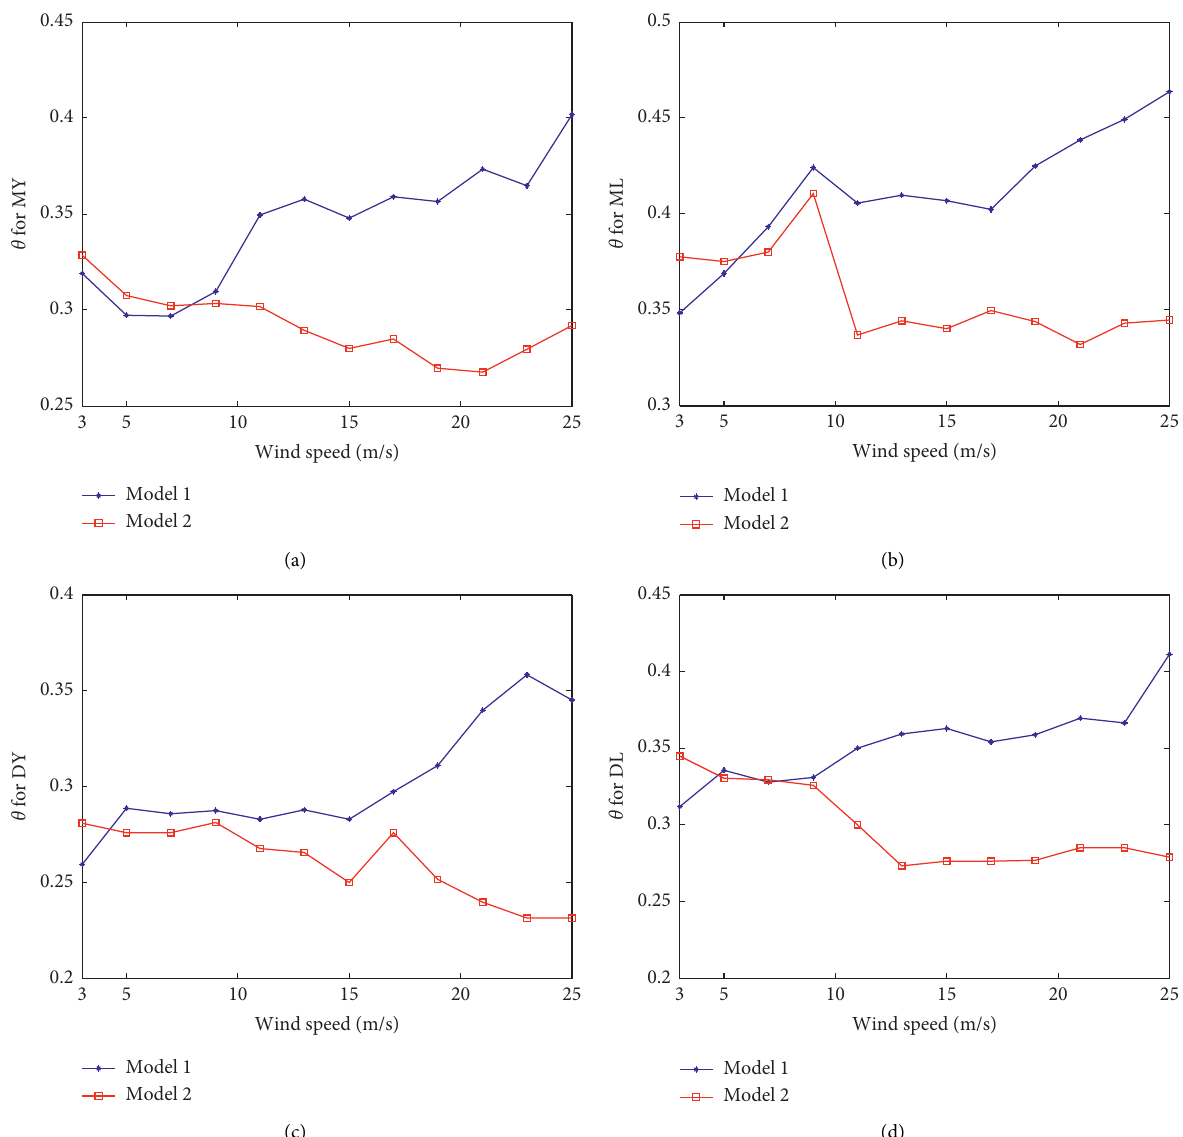
Figure 10: Comparison of the estimated β with different wind speeds between the two models: (a) MY, (b) ML, (c) DY, and (d)